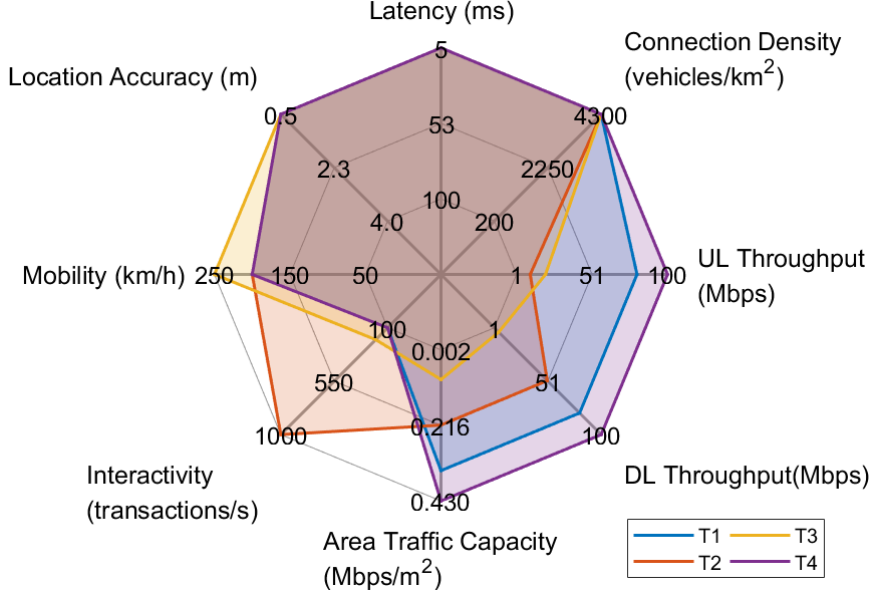
Figure 3. Radar chart of transport use